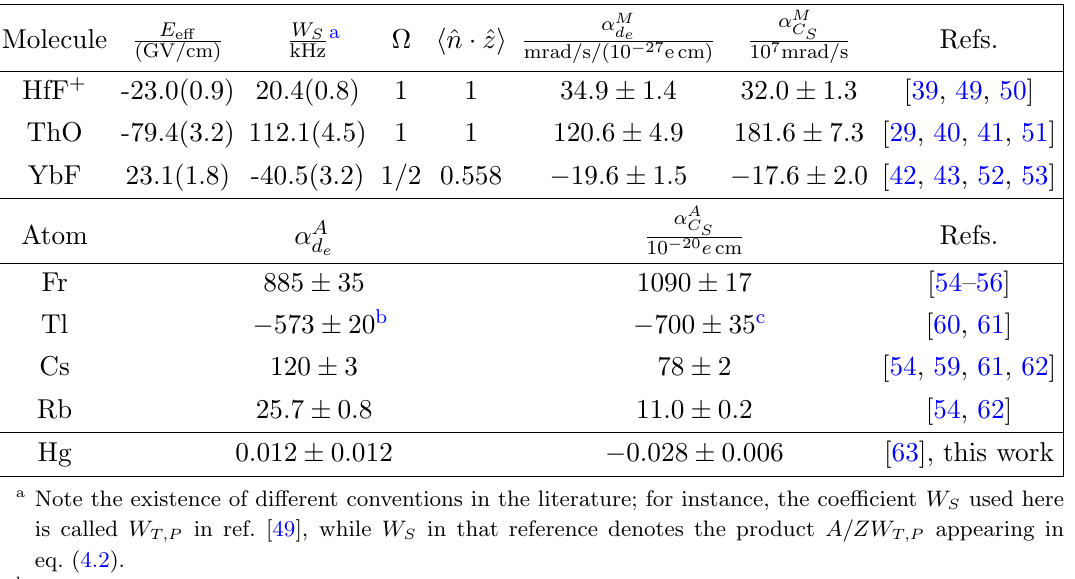
Table 4 . Relevant information regarding the systems under consideration. (cid:11) A